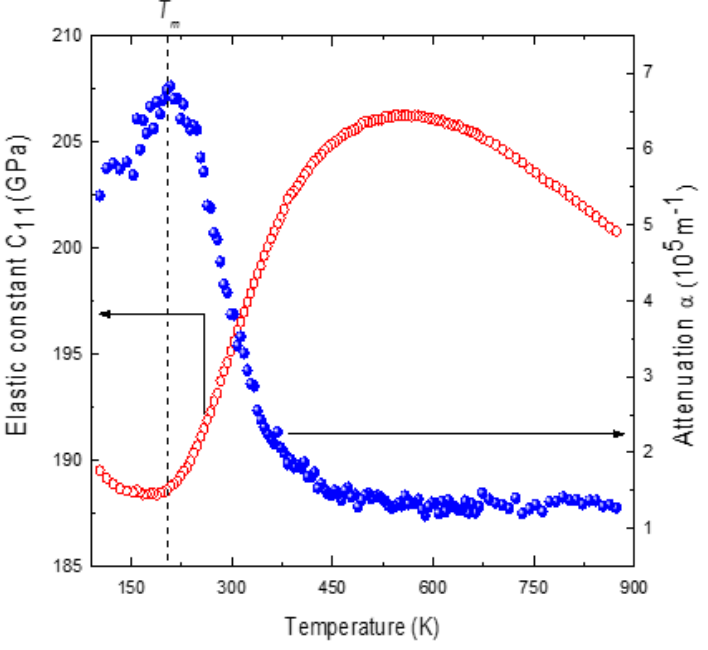
Figure 2. Temperature dependence of the elastic constant C 11 (open circles) and attenuation α (closed circles) of PMT (Reprinted with kind permission from Ref. [41]. 2015, the European Physical Journal (EPJ)).